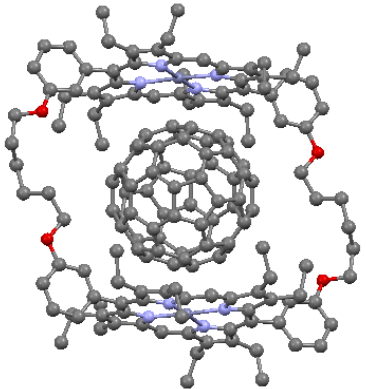
Figure 19. Inclusion complex of C 60 in cyclic Zn-porphyin dimer, from data in [7,55]. Dark blue = Zn, red = O.